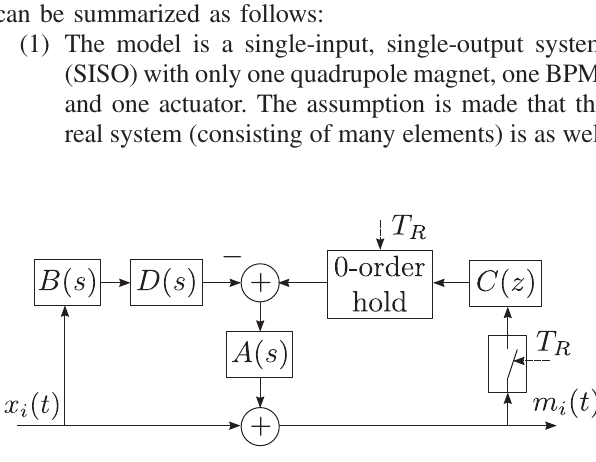
FIG. 1. Schematic diagram of the feed-forward mitigation system including an orbit feedback controller C ð z Þ for the suppression of relatively slow